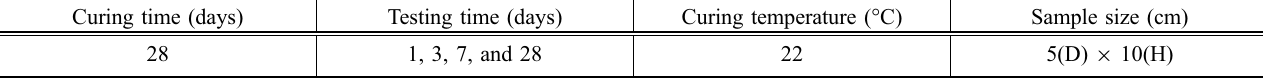
Table 5 Testing program in Case Study 2.